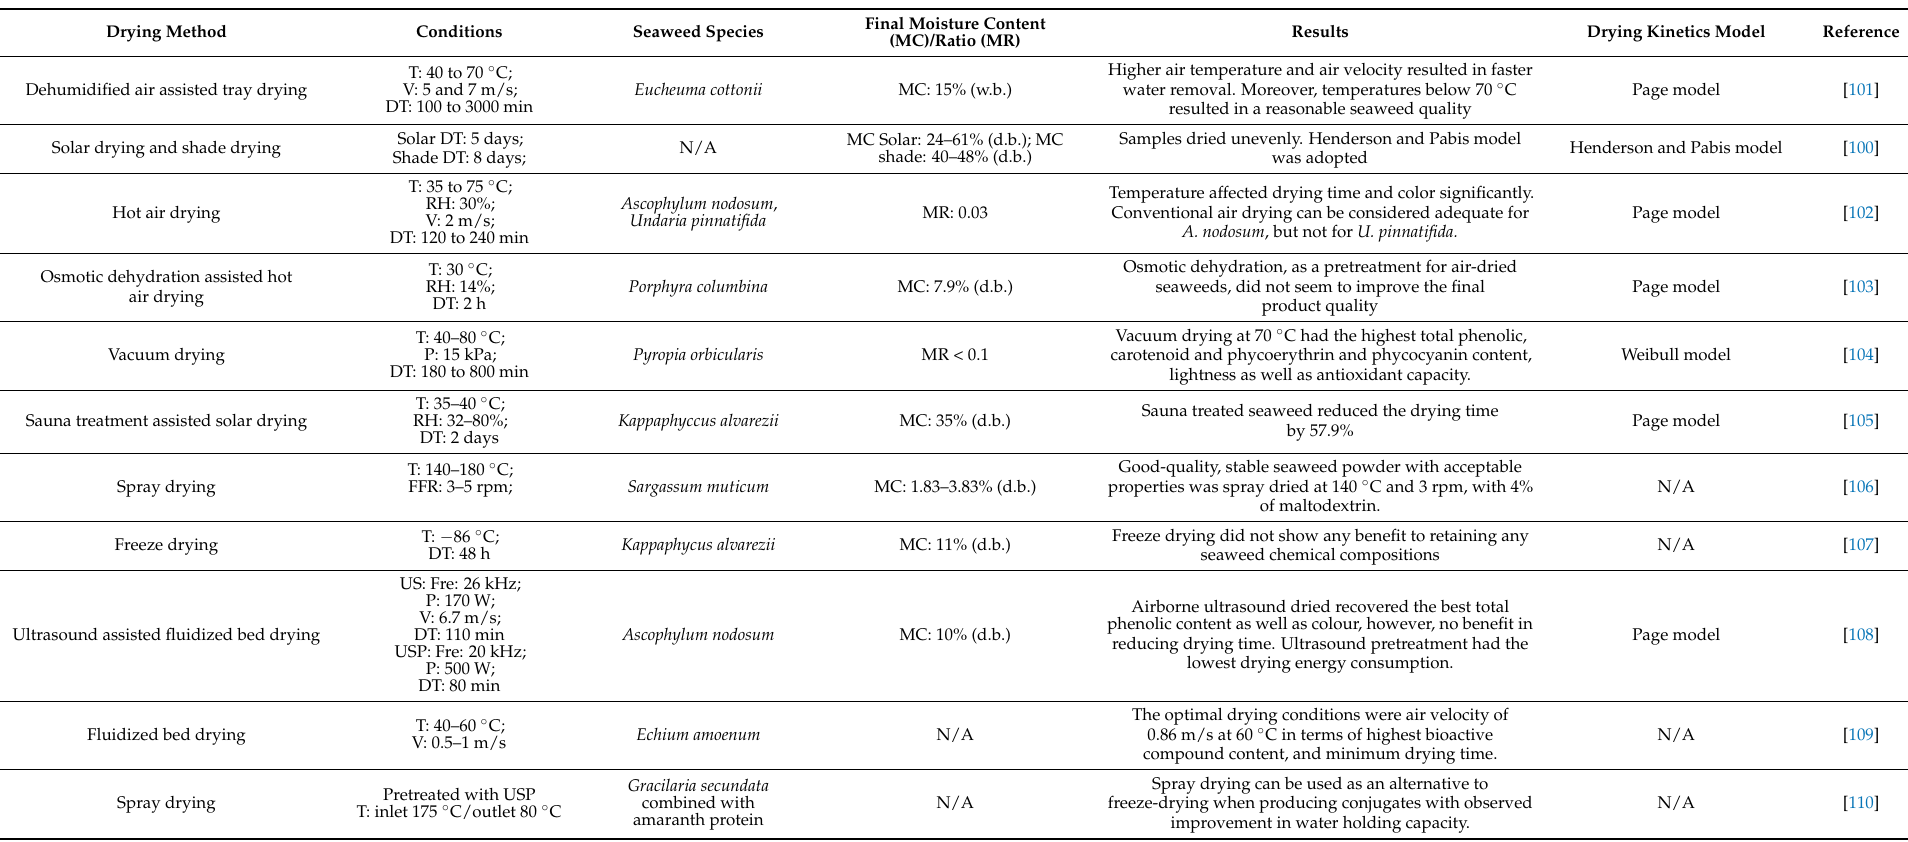
Table 4. An overview of various drying technologies used in seaweed processing, adapted with permission from [93]. 2021 Zhu et